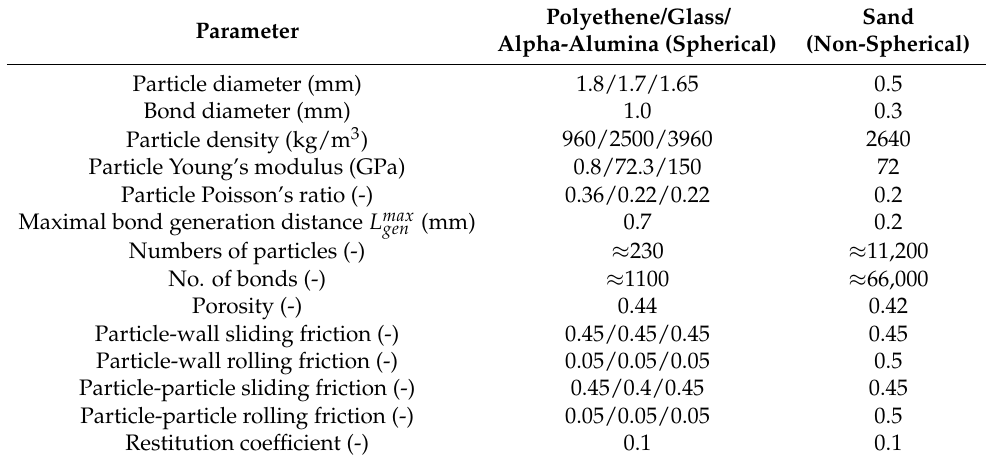
Table 3. Main agglomerates properties used for simulation of different types of PFS with 100% saturation